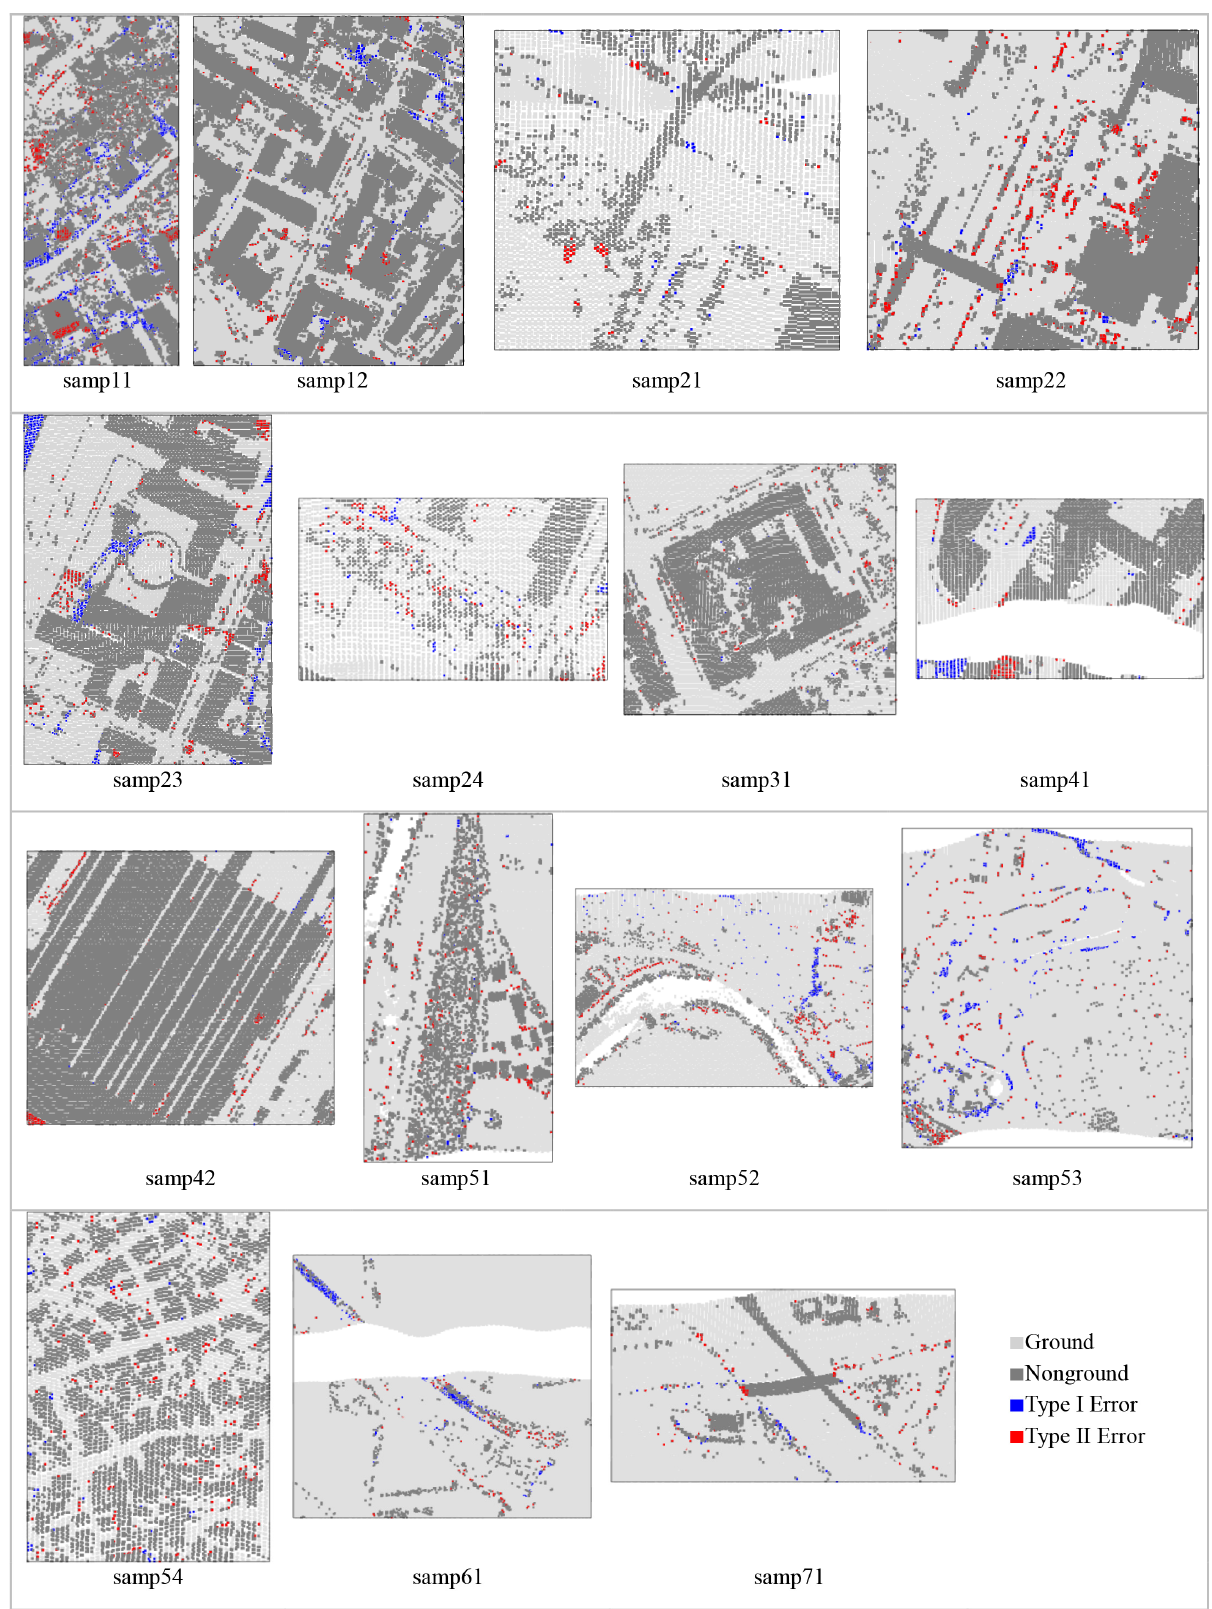
Figure 6. Error distributions of the ASI filtering results for each sample.